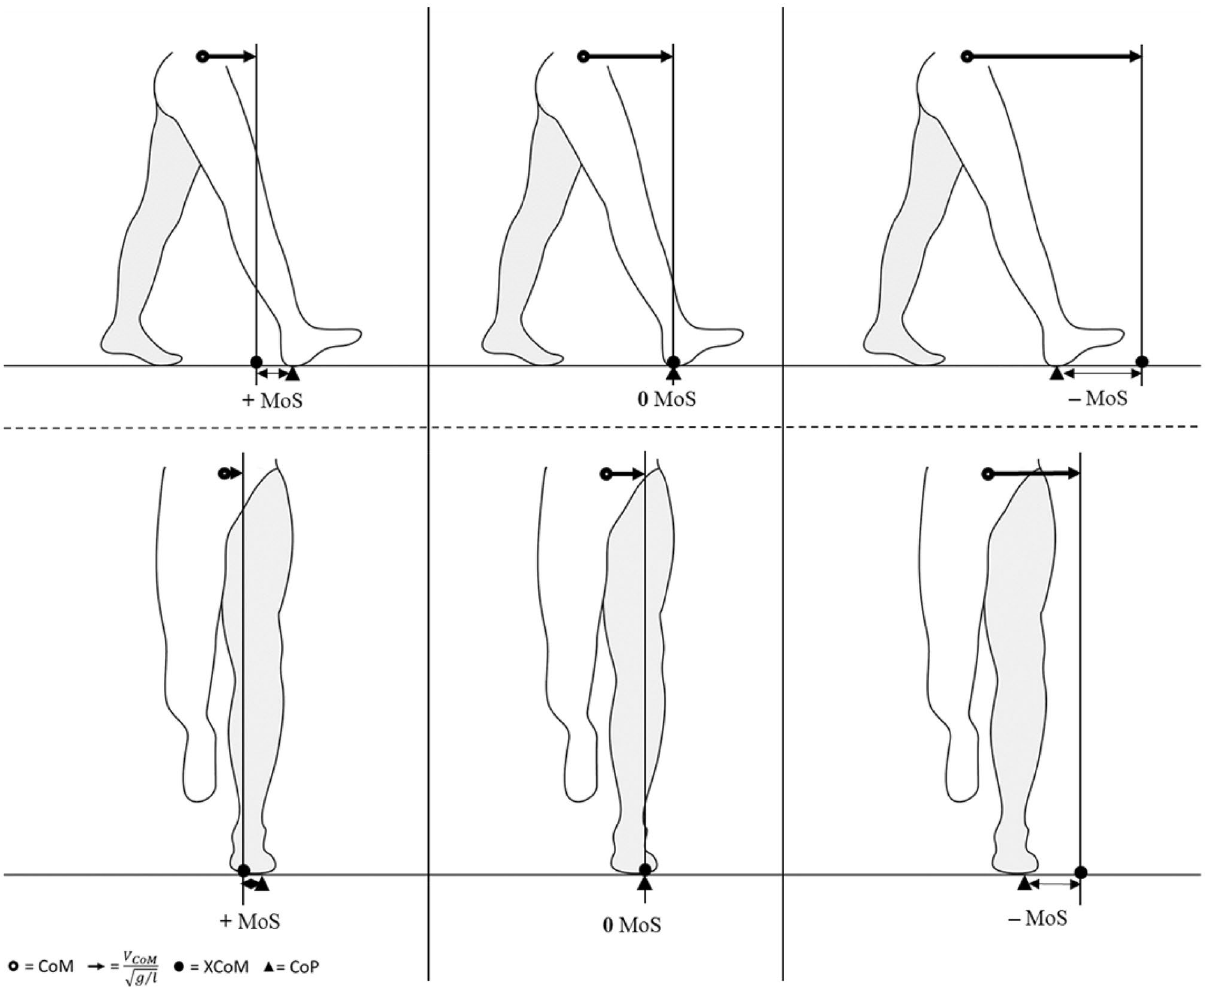
Figure 1. Schematic representation of the spatial margins of stability (MoS) in anterior–posterior (AP) direction at foot contact (top row), and medio-lateral (ML) direction during single support (bottom row). Left: The extrapolated centre of mass (XCoM) falls behind and medially of the centre of pressure (CoP), i.e., within the base of support, leading to a positive margin of stability (MoS) and resulting in the CoM reversing its motion if no further action is taken; Middle: the XCoM is projected right above the CoP, resulting to a MoS of zero, leading to the CoM coming to a halt; Right: The XCoM is projected in front and laterally of the CoP, thus resulting in a negative MoS, allowing the CoM to continue its motion. This figure has been adapted from Hak, et al. 16 https:// doi. org/ 10. 1371/ journ al. pone. 00828 42. g001 in compliance with the CC BY 4.0